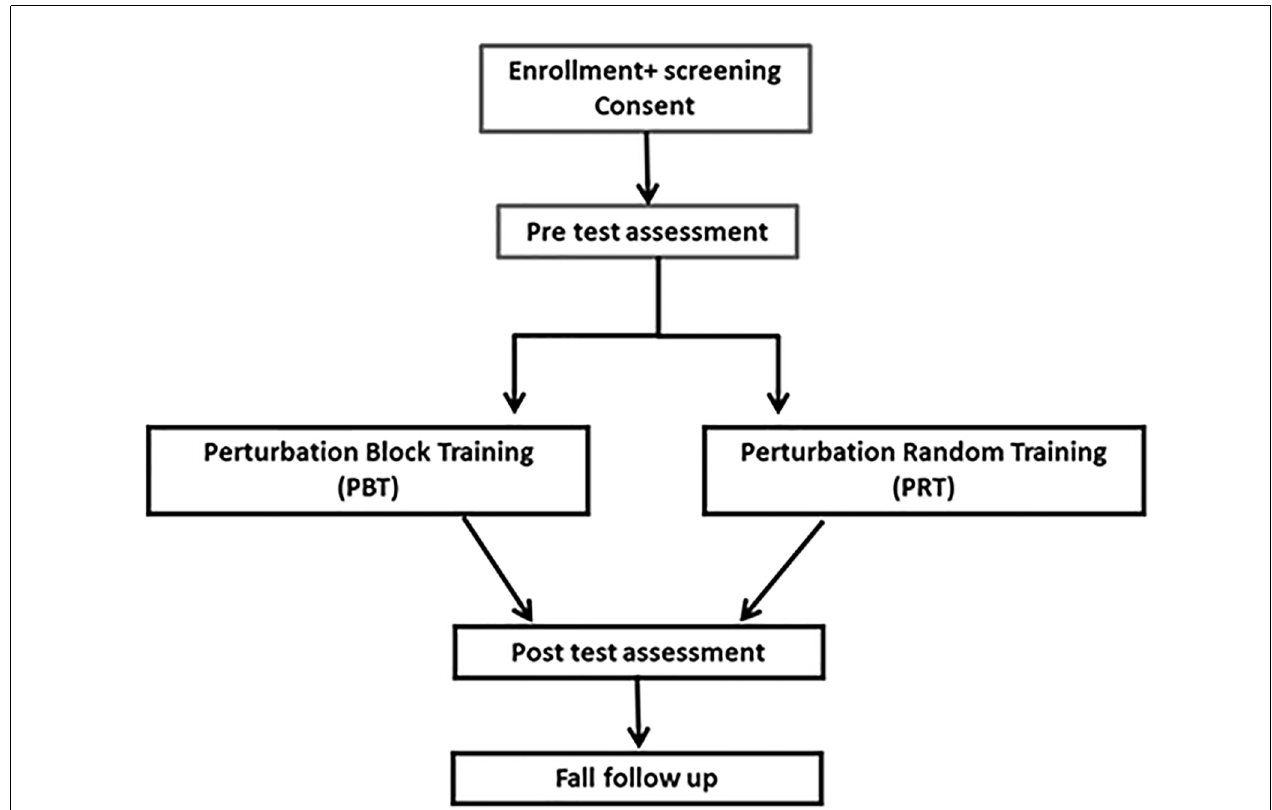
FIGURE 1 | Study flowchart.